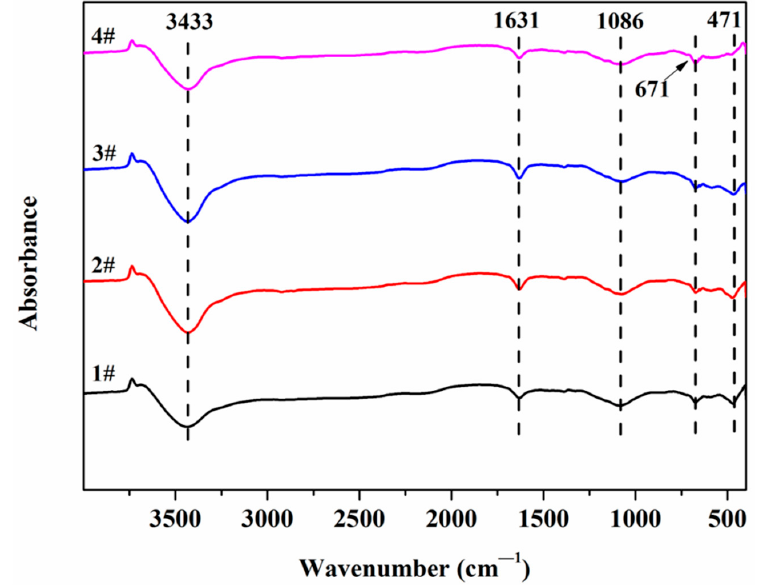
Figure 5. FTIR spectra of each carbonaceous deposit layer in the coking chamber.